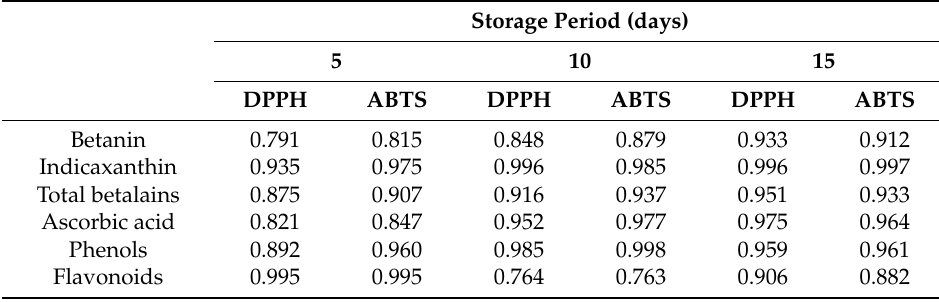
Table 5. TheRvalues(Pearsoncorrelationcoefficients)betweenantioxidantactivitiesandbioactivecompounds. Storage Period